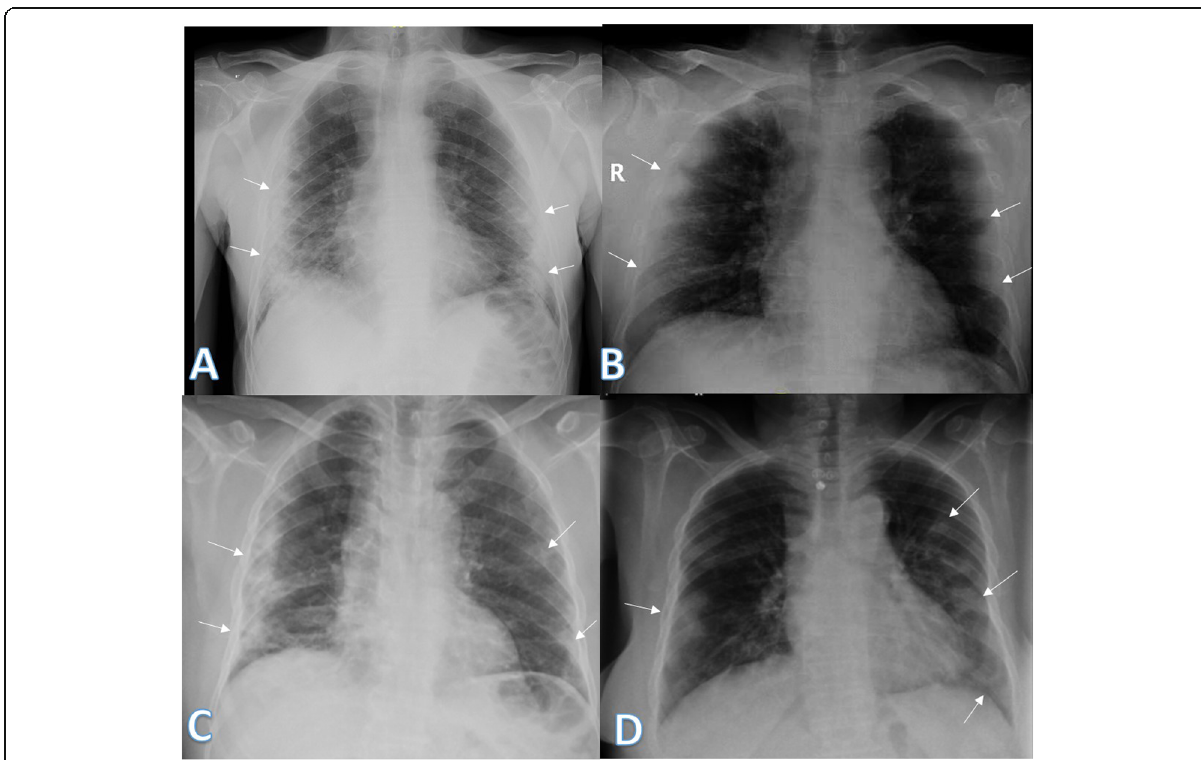
Fig. 1 Four different patients with positive COVID-19. a 72-year male was complaining of fever and cough. Initial chest X-ray showed bilateral peripheral mid and lower zonal air space consolidation opacities (arrows). The severity score was 2 for each lung, so TSS was 4. b 44-year male was complaining of SOB, cough, and fever. Initial chest X-ray showed bilateral peripheral zonal air space consolidation opacities along the periphery of both lungs (arrows). The severity score was 2 for each lung so, TSS was 4. c 63-year male was complaining of cough and fever. Initial chest X-ray showed right peripheral mid and lower zonal air space consolidation opacities (arrows), smaller patches of consolidation is seen on the side (arrows), the severity score for the right lung was 2 and for the left lung was 1, so TSS was 3. d 68-year female patient was complaining of SOB and cough. Initial chest X-ray showed bilateral air space consolidation opacities (arrows) of peripheral midzonal distribution in the right lung and neither peripheral nor perihilar mid and lower zonal distribution in the left lung (arrows). The severity score for the right lung was 1 and for the left lung was 2, so the total severity score was 3